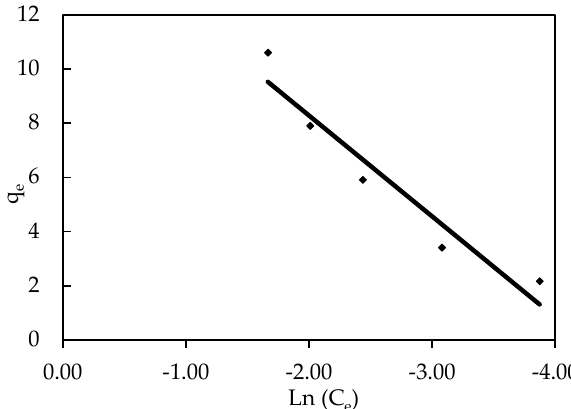
Figure 14. Tempkin isotherm of the removal of IV2R on ZnO ‐ NP.